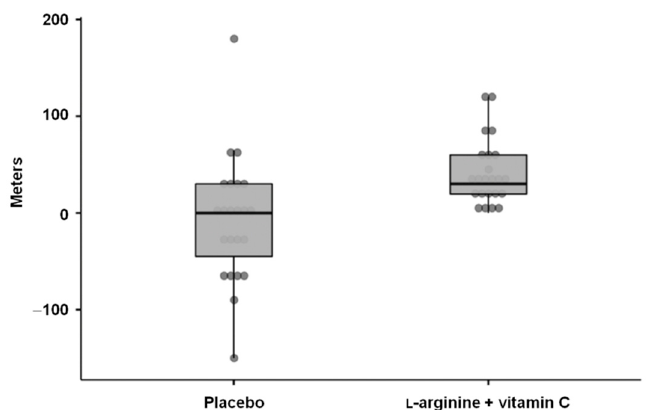
Figure 3. Changes from baseline to day 28 in the 6 min walk test distance in the two intervention groups.